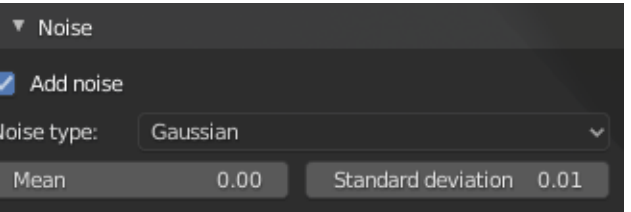
Figure 7. The screenshot shows the menu for configuring the random error. Here the normal distribution can be selected and parameterized by the mean and standard